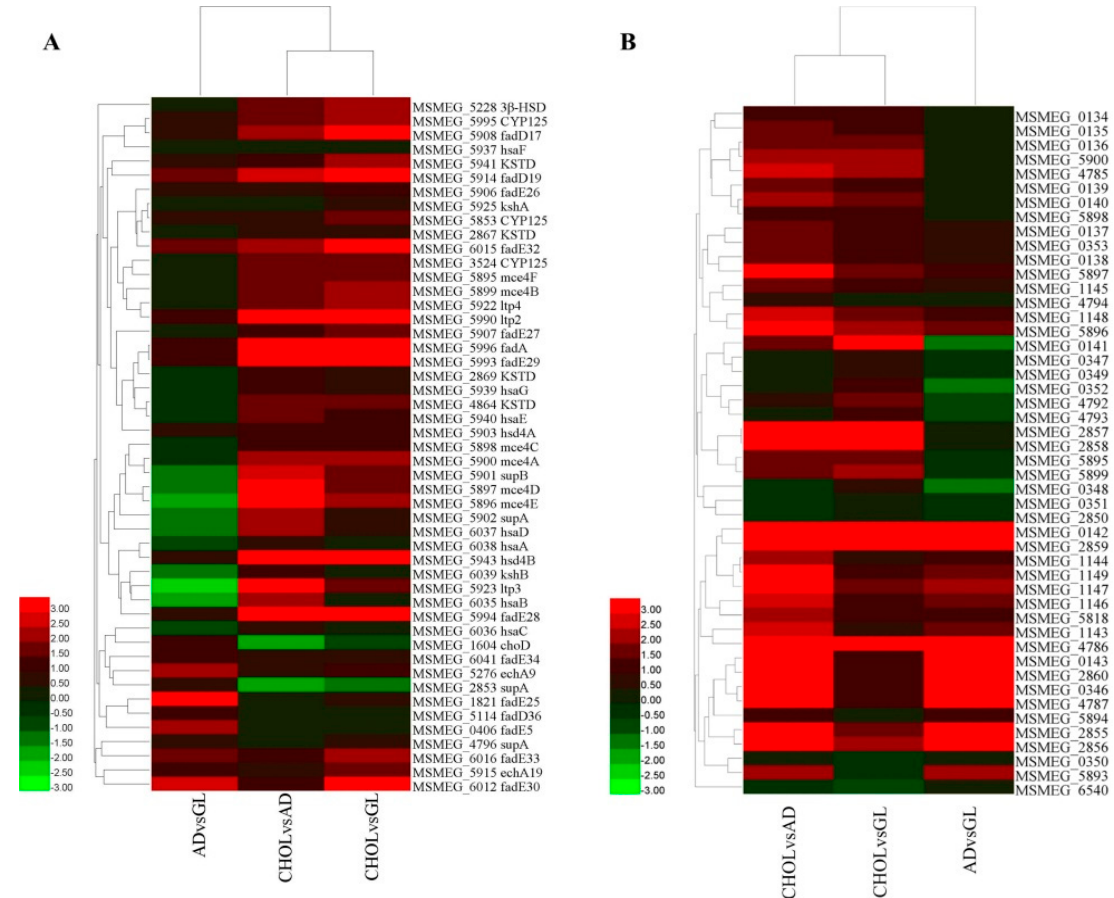
Figure 3. Expression patterns of cholesterol pathway ( A ) and mammalian cell entry (MCE) ( B ) related genes. Log 2 fold-change (Log 2 FC) was calculated between each two conditions basing on the expression value. Heatmap was drawn by HemI.